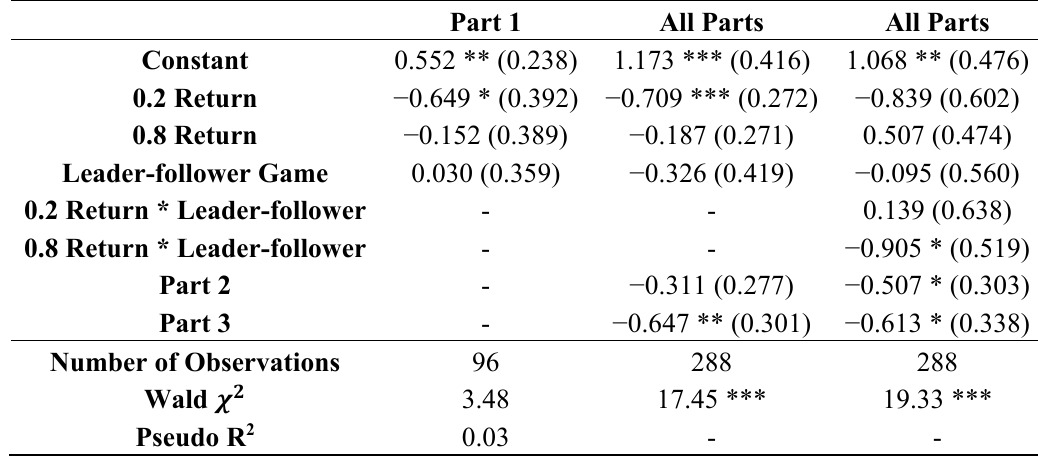
Table 3. Results of two probit regressions with conditional cooperator as dependent variable, using the data from part 1 or the full sample. A panel regression is used for all parts. Part 1 All Parts All